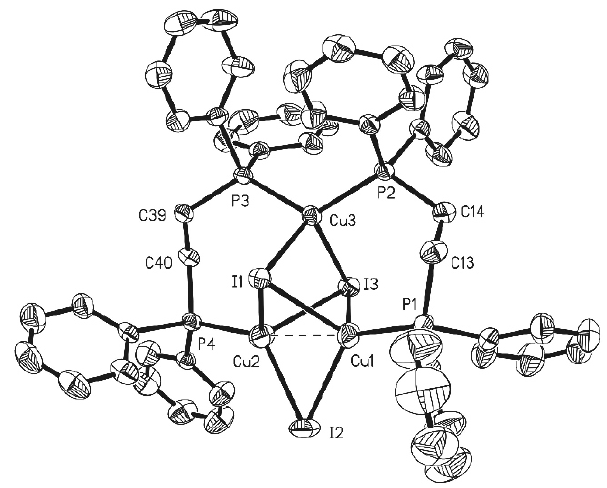
Table 1. Data collection and handling.